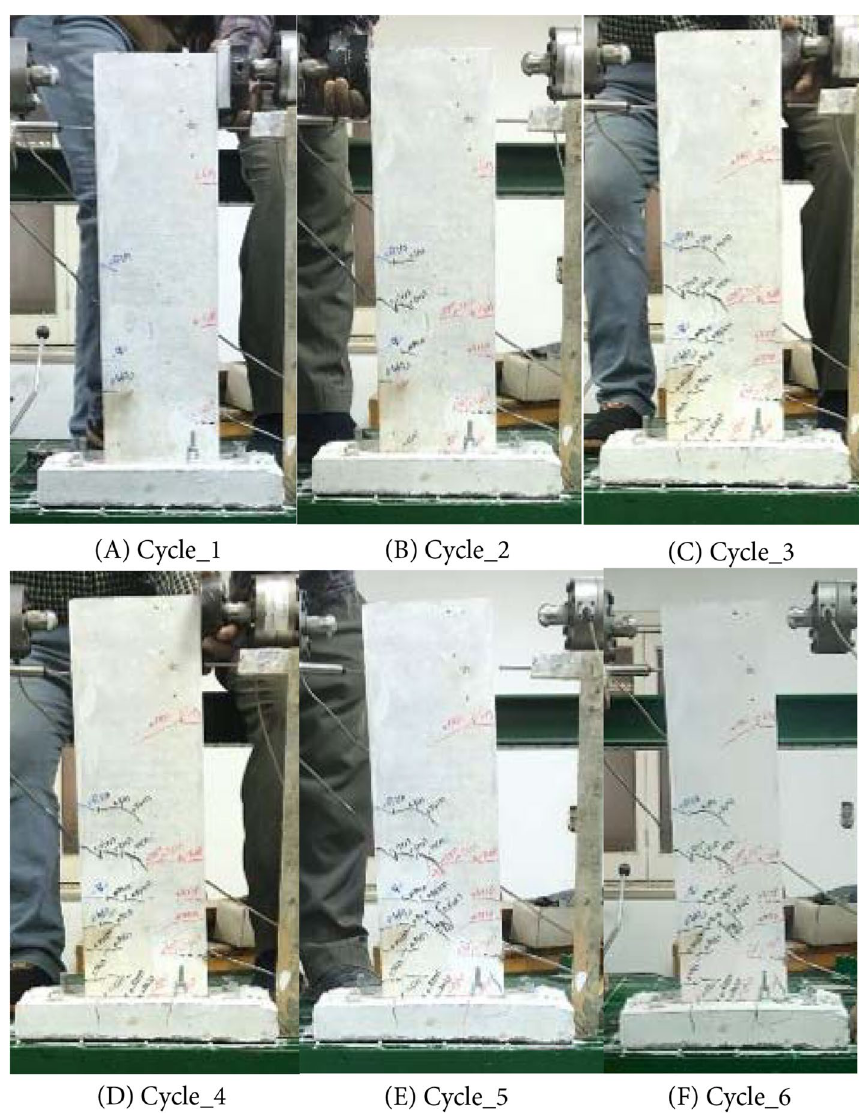
Fig. 14 The crack pattern after each loading cycle A first cycle, B second cycle, C third cycle, D fourth cycle, E fifth cycle, and F sixth cycle